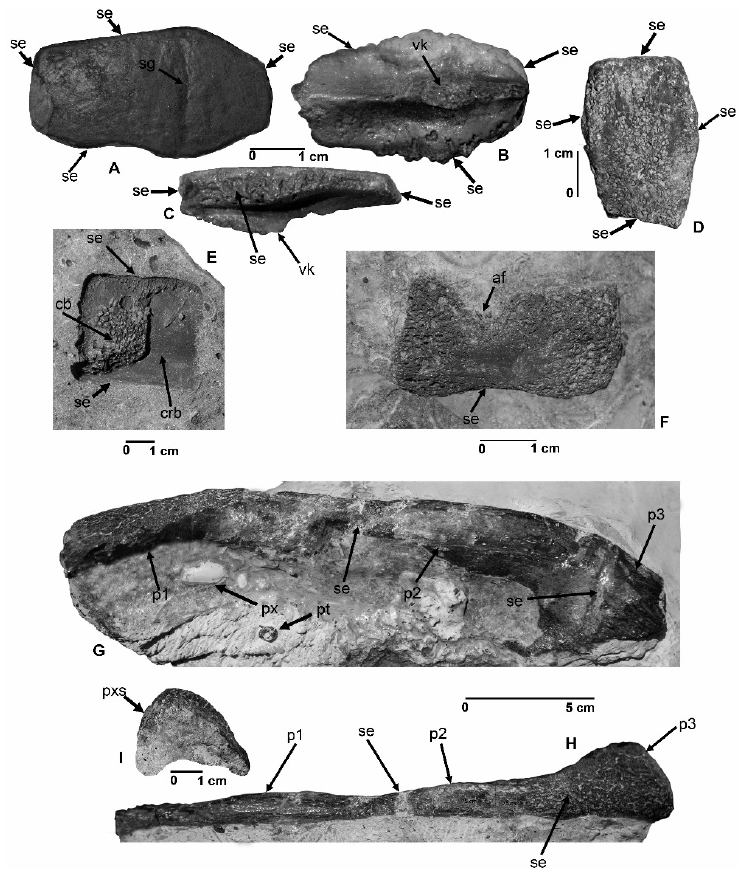
Figure 4. Turtle neurals and peripherals from the basalmost Midway Group lag deposit, Hot Spring